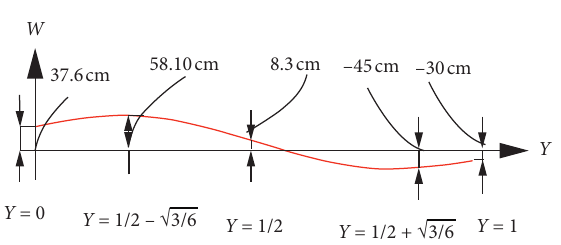
Figure 12: The coordinate graph of the spline